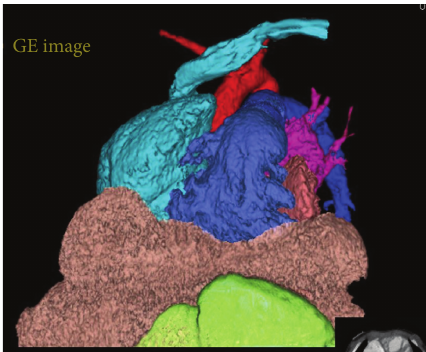
Figure 2: 3D color coded cardiac CTA frontal projection shows bilateral focal liver (tan) herniating up through the anteromedial aspect of the diaphragm in front of the right atrium (purple) and right atrium (light